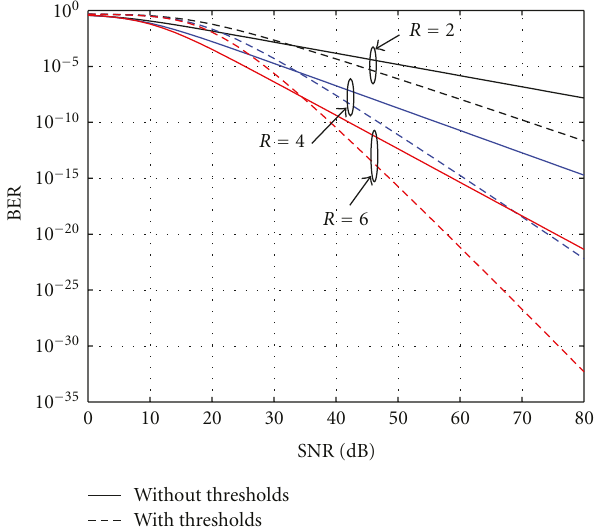
Figure 1: Diversity performance comparison with and without the SNR thresholds for di ff erent numbers of the relays.